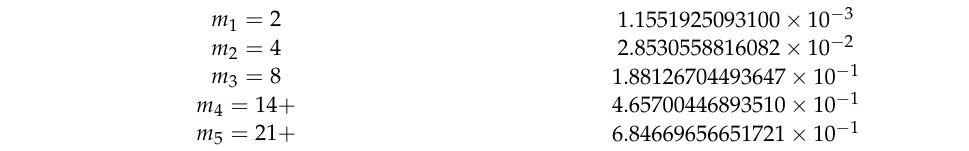
Table 2. Values of Θ m , 1 ≤ k ≤ 5, for polynomial evaluation using the Sastre k